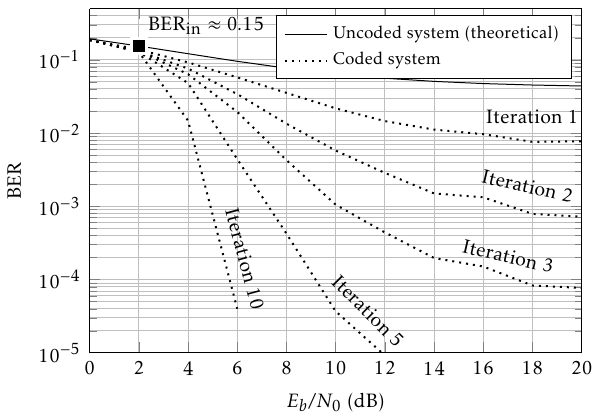
Figure 7. BER as a functionof E code, ρ = 4 / 3 and a TFL generator for 10 iterations of the